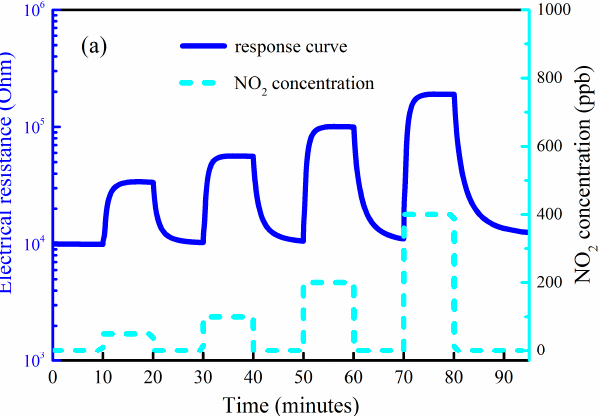
Figure 4. The electrical resistance of the rGO@ZnO 1 − x nanocomposites versus NO 2 gas in 50, 100, 200 and 400 ppb illuminated by white light at room